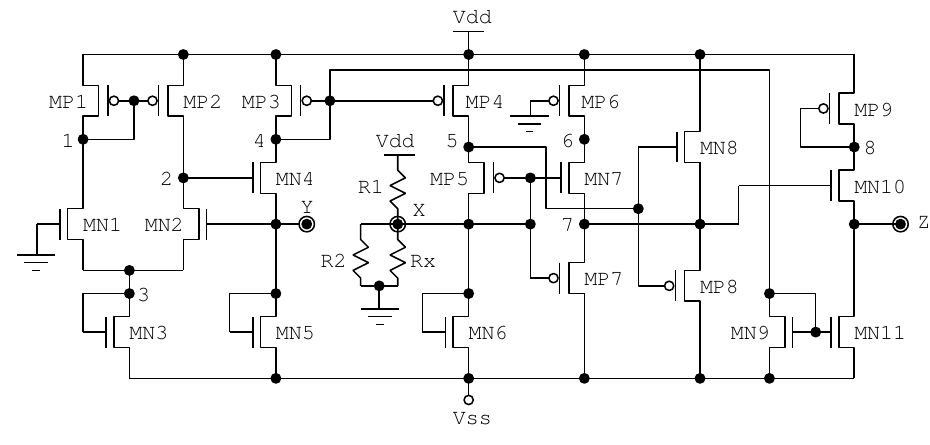
Figure 6. Schematic for the proposed TIA.